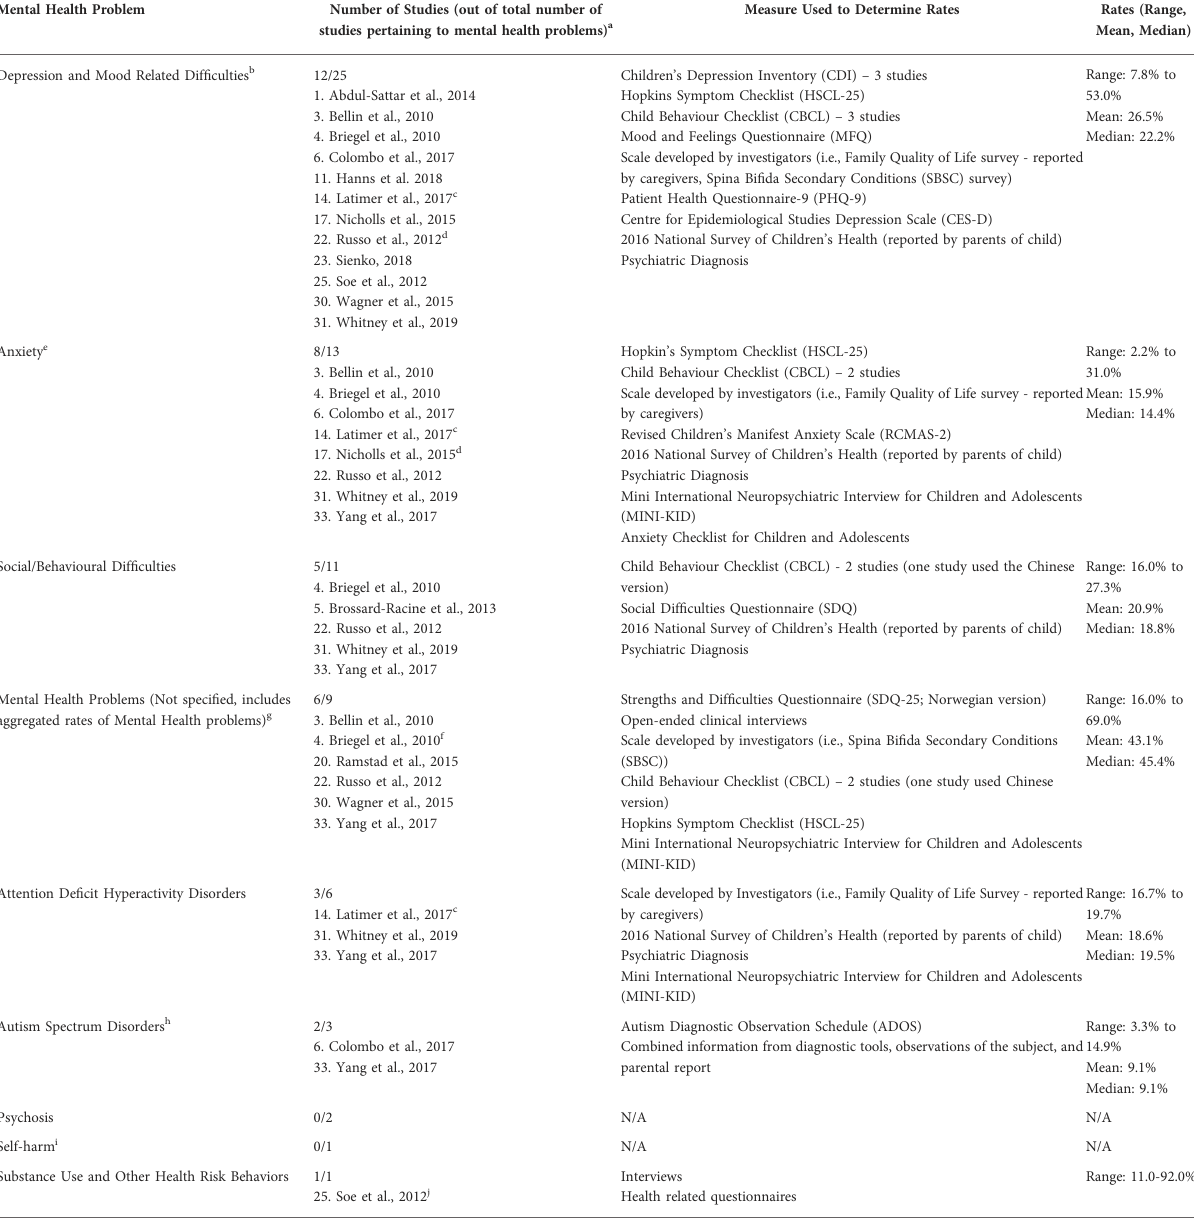
TABLE 4 Studies reporting rates of mental health